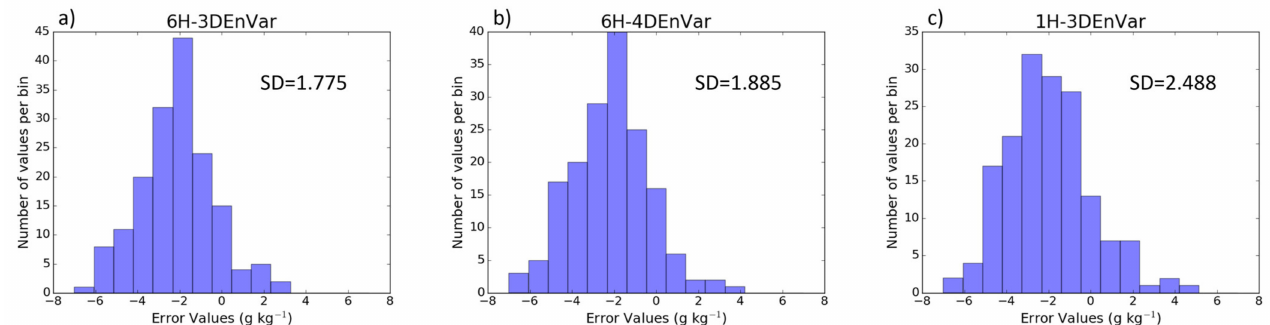
Figure 12. Analysis specific humidity error for the 700–900 mb layer as calculated against dropsonde observations for batch E2 for ( a ) 6H-3DEnVar, ( b ) 6H-4DEnVar, ( c )